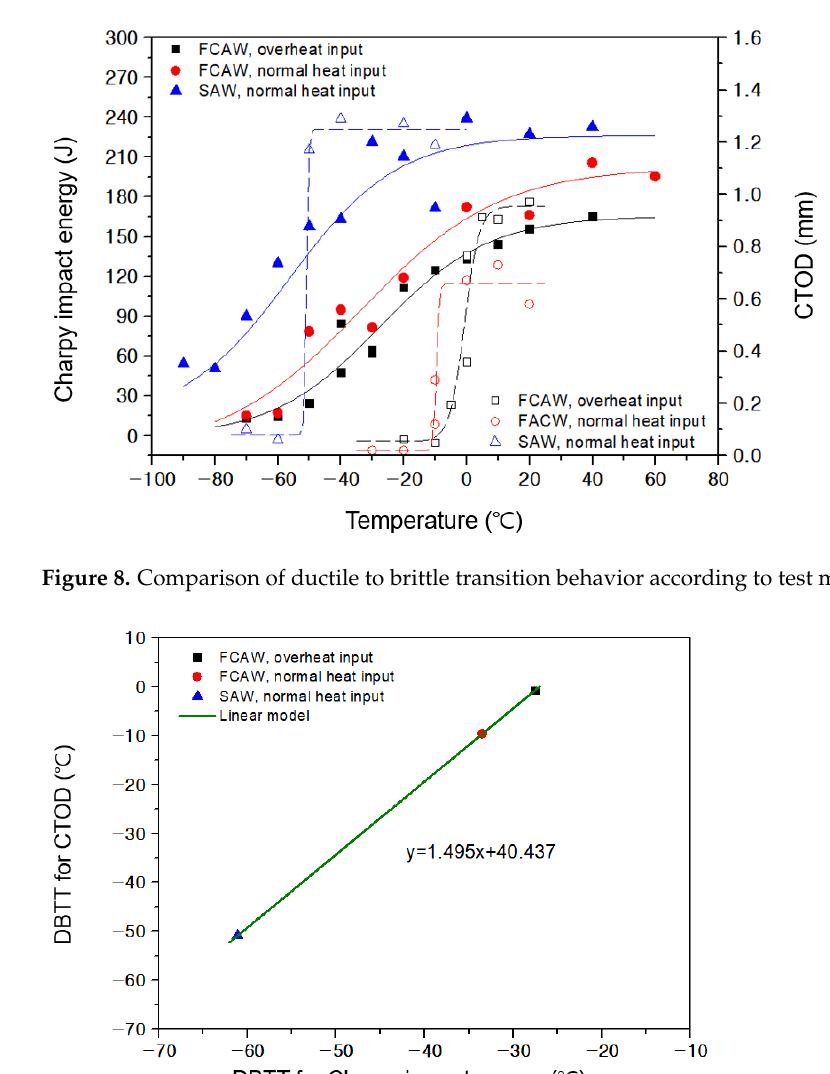
( b ) Figure 7. CTOD test results: ( a ) CTOD transition curve according to heat input; ( b ) CTOD transition curve according to welding method. 3.4. Comparison between Charpy and CTOD Transition Curve Although the test specimens are manufactured using the same material and welding